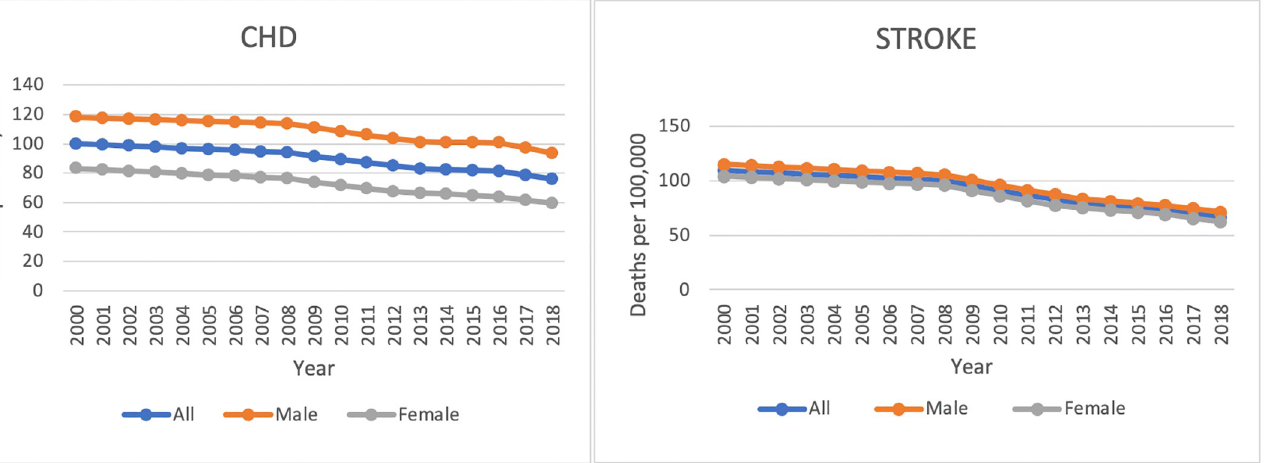
PLOS ONE | https://doi.org/10.1371/journal.pone.0253639 September 2,